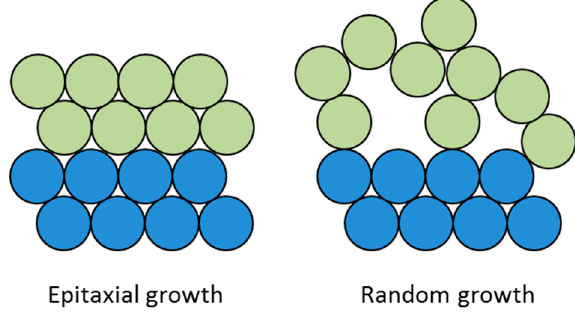
Figure 10. Schematic of crystal growth.